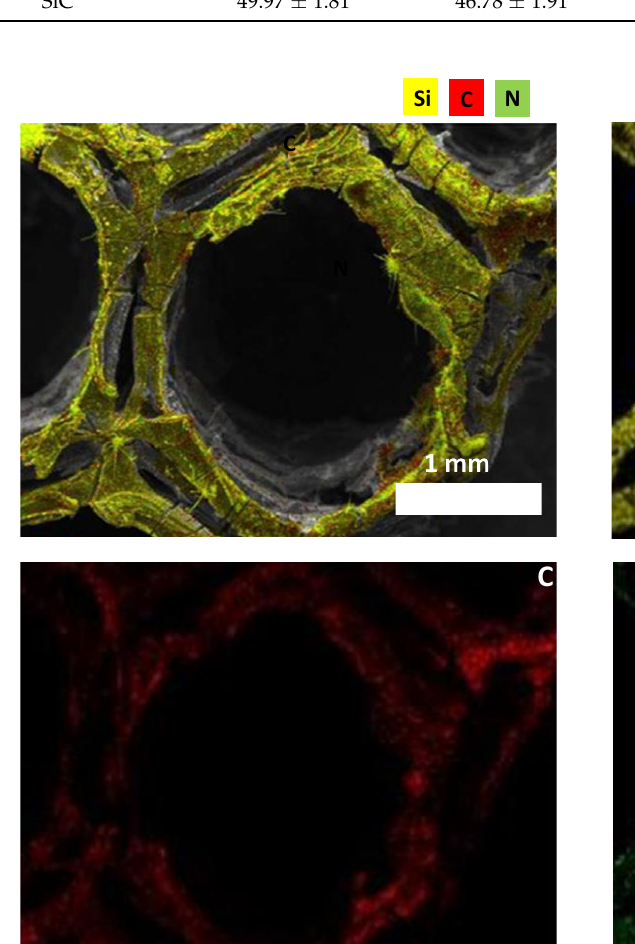
Figure 4. Elemental mapping of 3D SiCN.